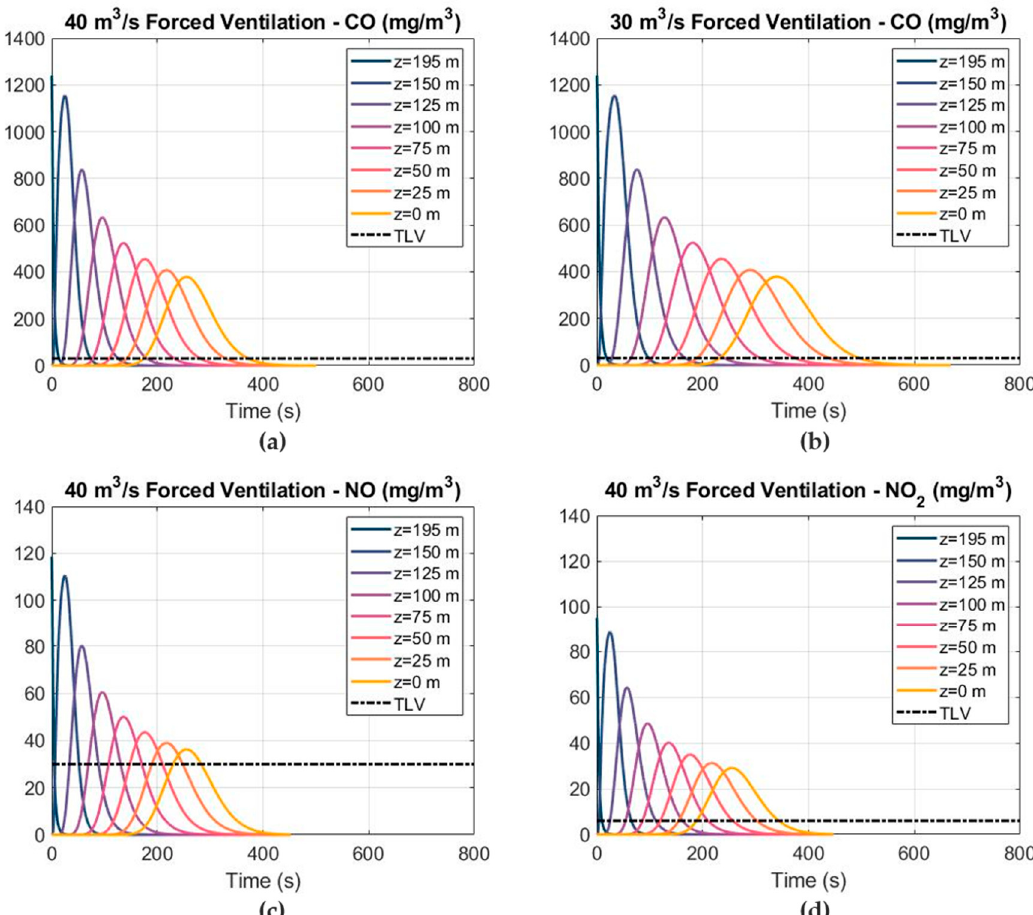
Figure 12. The results of the 1D model, showing the distribution of the toxic gas mass concentrations and TLVs at different cross sections and airflows under forced ventilation: ( a ) CO mass concentration at 40 m 3 s − 1 ; ( b ) CO mass concentration at 30 m 3 s − 1 ; ( c ) NO mass concentration at 40 m 3 s − 1 ; and ( d ) NO 2 mass concentration at 40 m 3 s − 1 .